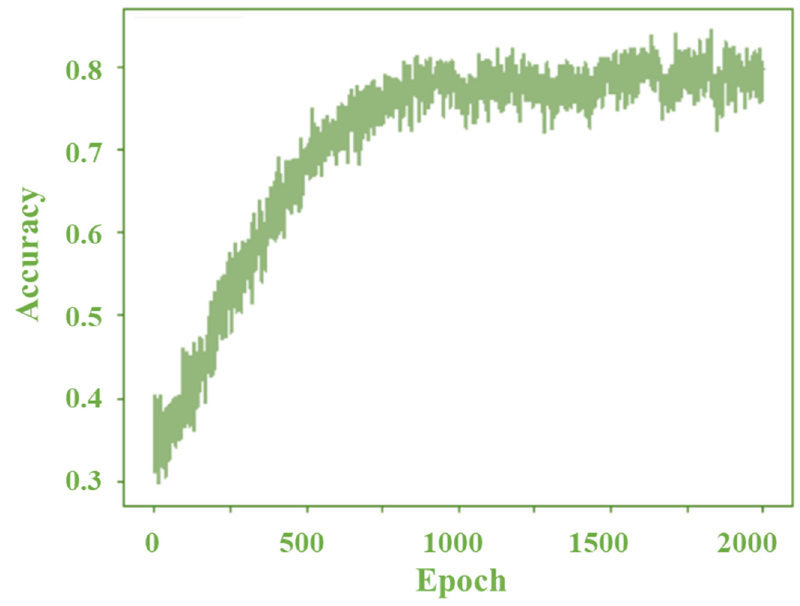
Figure 9. Diagnosis results of the proposed CNN model.